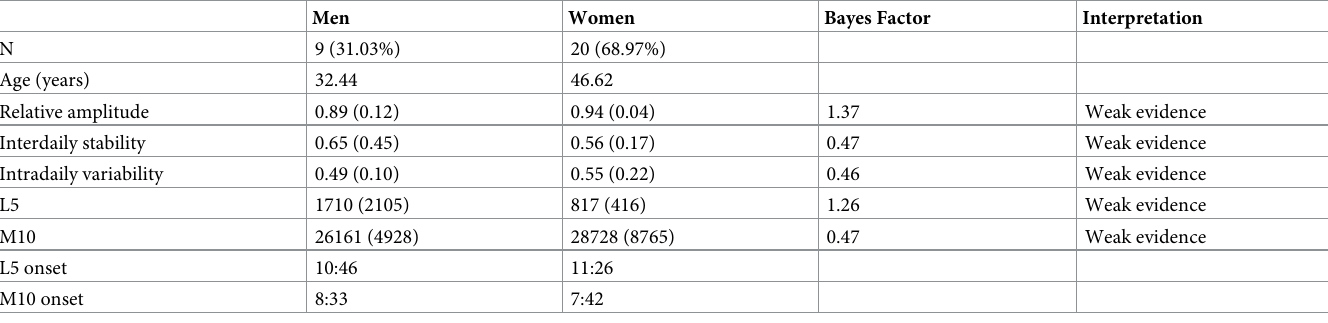
Table 4. Descriptive statistics: Mean (SD) and statistical tests for gender differences in circadian rhythm.